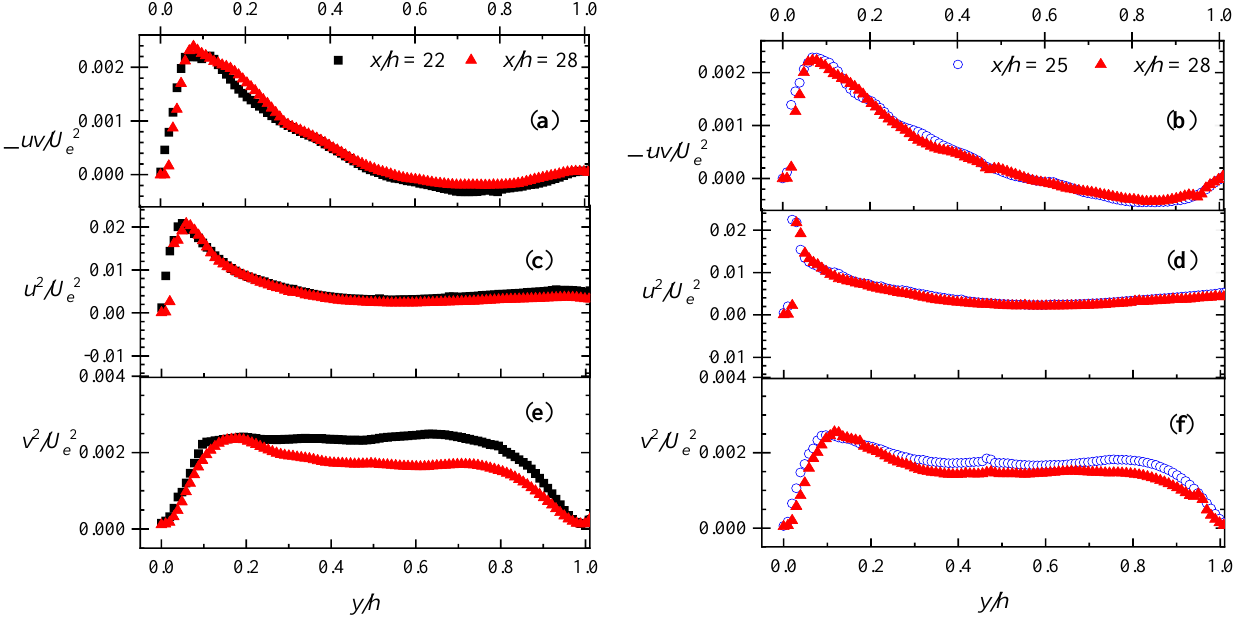
Figure 3. Wall-normal variations of Reynolds shear stresses ( a , b ), streamwise components of Reynolds stresses ( c , d ), and wall-normal components of Reynolds stresses ( e , f ). These profiles are extracted at x/h = 22, 28 for test condition AR 1.5 Re 165 Fr 0.13 (shown in ( a , c , e )) and x/h = 25, 28 for test condition AR 1.3 Re 452 Fr 0.17 (shown in ( b , d , f )). All velocities are normalized by the local maximum velocity, and the lengths are normalized by the respective depth of the flow.